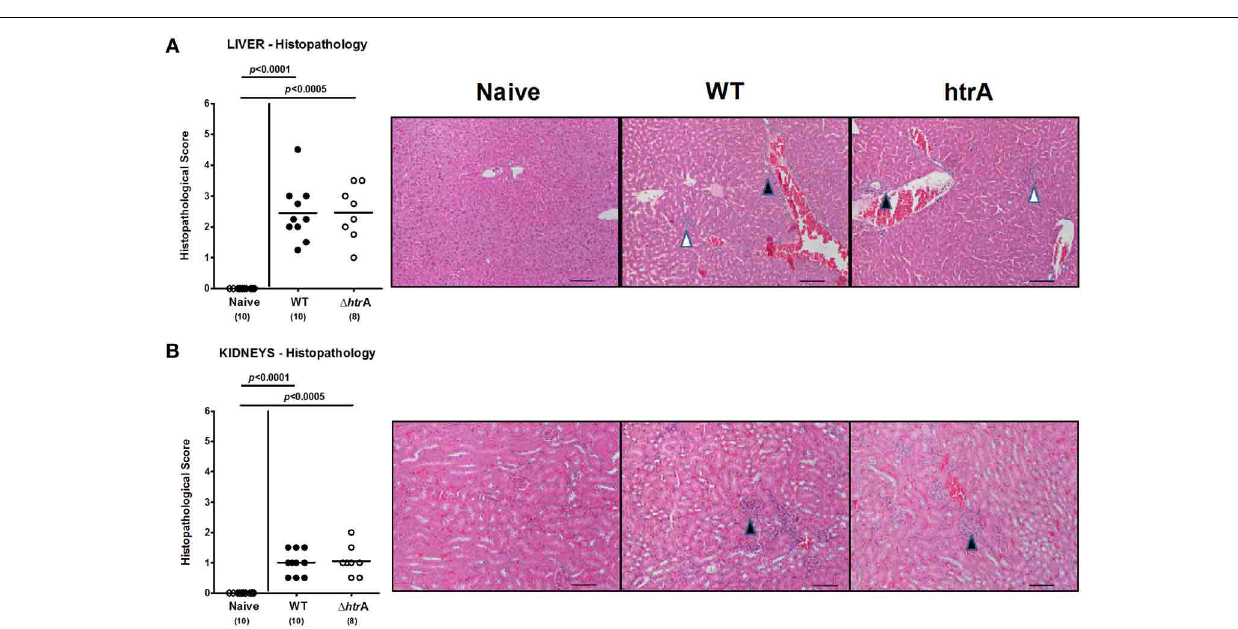
representative photomicrographs (400 × magnification, scale bar 20 μ m). In liver sections, black arrow heads indicate portal and white arrow head lobular inflammatory infiltrates. In kidney sections, black arrow heads point to focal hypercellularity. Data shown were combined from three independent